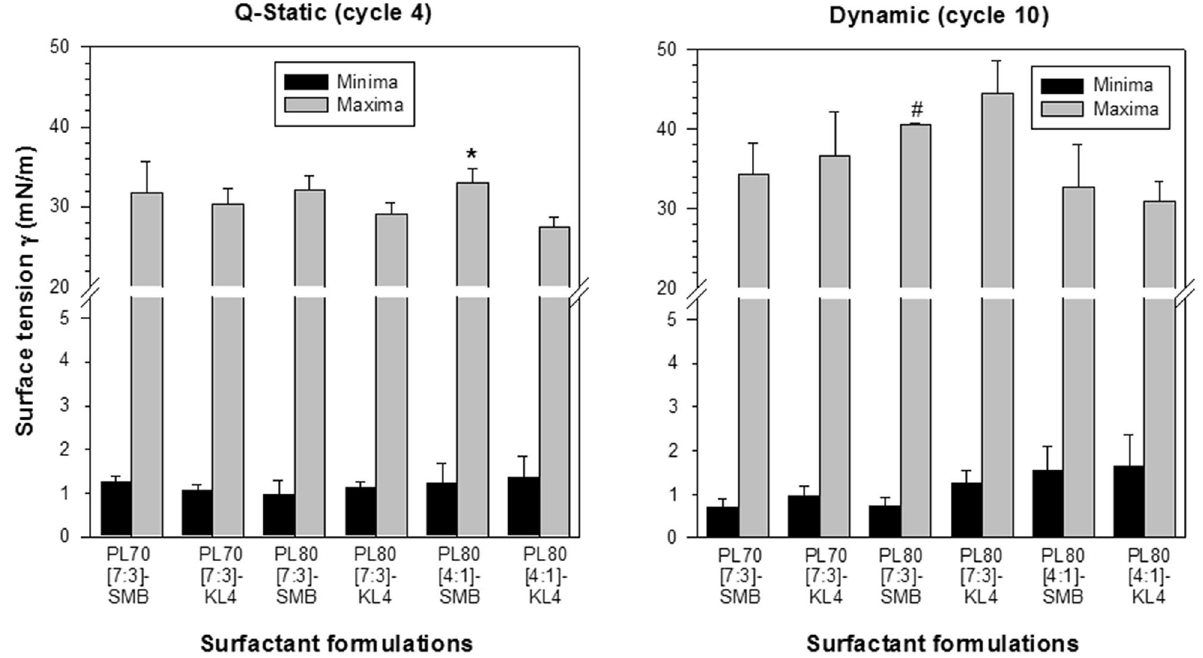
Figure 3. Mean ± SEM quasi-static (cycle 4) and dynamic (cycle 10) cycling data of the six dry powder surfactant preparations from the 1st series at captive bubble surfactometry. Formulations PL70[7:3]-SMB, PL80[7:3]-SMB and PL80[4:1]-SMB contained Super Mini-B (SMB) and formulations PL70[7:3]-KL4, PL80[7:3]-KL4 and PL80[4:1]-Kl4 contained KL4 as surfactant protein B (SP-B) peptide mimic. PL70 and PL80 stand for 70% and 80% phospholipids, [7:3] and [4:1] for DPPC:POPG ratios. Black bars depict minimum surface tension and gray bars maximum surface tension at quasi-static cycle 4 (left-sided figure) and dynamic cycle 10 (right-sided figure) (n = 3–4). *p = 0.04 vs PL80[4:1]-KL4; # p = 0.02 vs PL80[4:1]-KL4. See Table 1 for details on composition of the